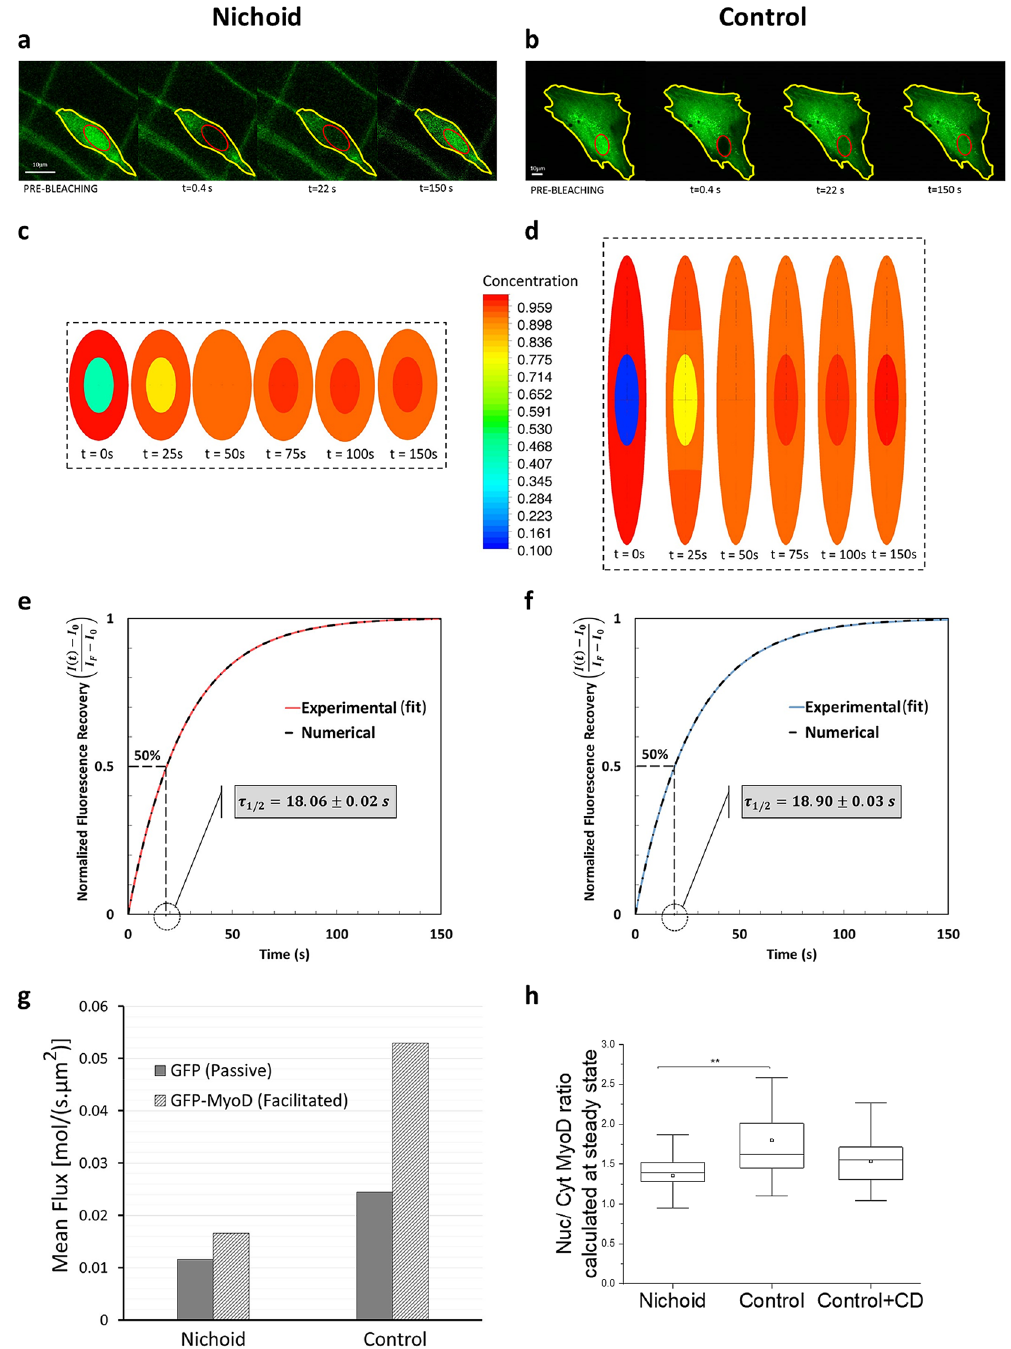
Figure 7. Facilitated transport through the MSC pore complexes. ( a,b ) Representative FRAP experiment on MSCs expressing GFP-MyoD protein, grown in the Nichoid ( a ) and on the control substrate ( b ). ( c ) Contour map of GFP-MyoD concentration on xz-plane at different time points for cells grown in the Nichoid (from numerical simulation). ( d ) Contour map of GFP- MyoD concentration on xz-plane at different times for cells grown on a flat control substrate (from numerical simulation). The software used to create the images ( c ) and ( d ) is Ansys 2019 R2 (www.ansys .com). ( e ) Comparison of fluorescence recovery curve for cells in the Nichoid: numerical simulation (gray), FRAP experiments (red). ( f ) Comparison of fluorescence recovery curve for Control cells; numerical simulation (gray), FRAP experiments (blue). The vertical axis of the graphs e and f shows the normalized fluorescence intensity for FRAP and the normalized concentration for the numerical simulation; the grey box inside these figures shows the half-life recovery time. ( g ) Comparison of mean fluxes (passive and facilitated) calculated by computational modelling, within the first 22 s after photobleaching for cells in the Nichoid and on the Control. ( h ) GFP- MyoD concentration in the cell nucleus at steady state conditions. The nuclear concentration in cells with thin disk-like shape is bigger than in MSCs with roundish nuclei. Graph ( h ) statistics: Kruskal–Wallis multicomparison test. *Corresponds to p <